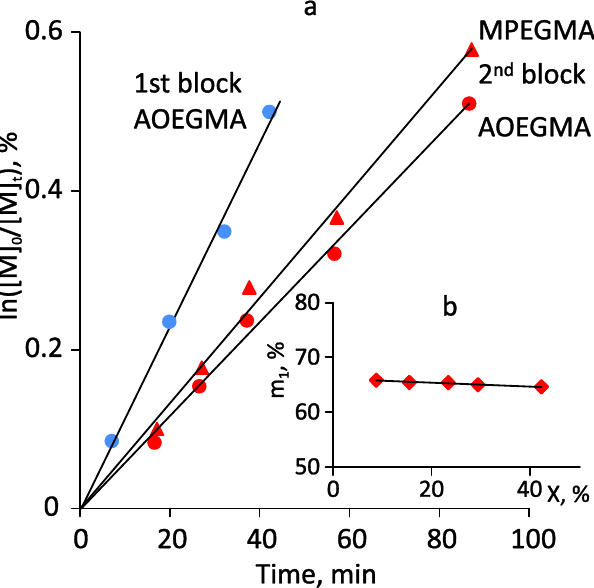
Figure 11. ( a ) Kinetic first-order plot for the photo-induced RAFT homopolymerization of AOEGMA (blue) and subsequent chain extension (red) with MPEGMA and AOEGMA in THF. ( b ) The plot of the 2nd block composition, m 1 , vs. conversion, X. m 1 , is the mole fraction of MPEGMA in a random 2nd block. Polymerization conditions for the first stage: ω AOEGMA = 50 wt.%, [AOEGMA] 0 /[CDTPA] 0 = 200:1, blue LED, 8.3 mW/cm 2 , 35 °C; second stage: ω monomers = 49 wt.%, [MPEGMA] 0 /[AOEGMA] 0 /[macroRAFT] 0 ≊ 800:480:1, blue LED, 8.3 mW/cm 2 , 35 °C.